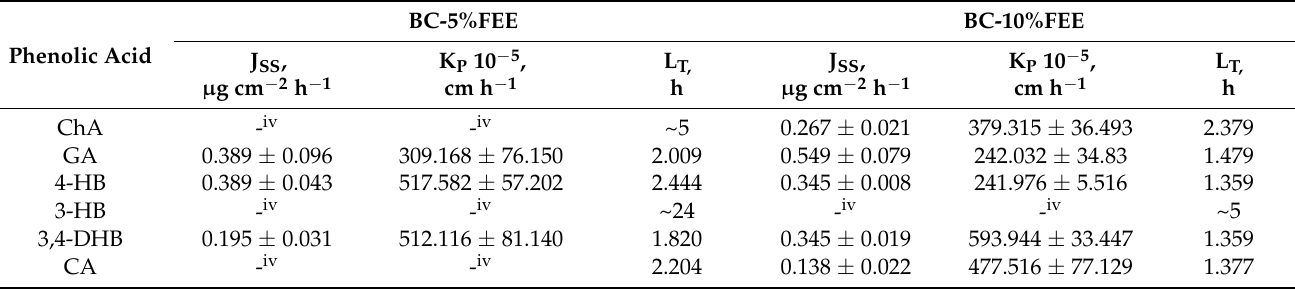
Table 6. The parameters characterizing phenolic acids transport through the pigskin after application of BC-FEEs in penetration study.